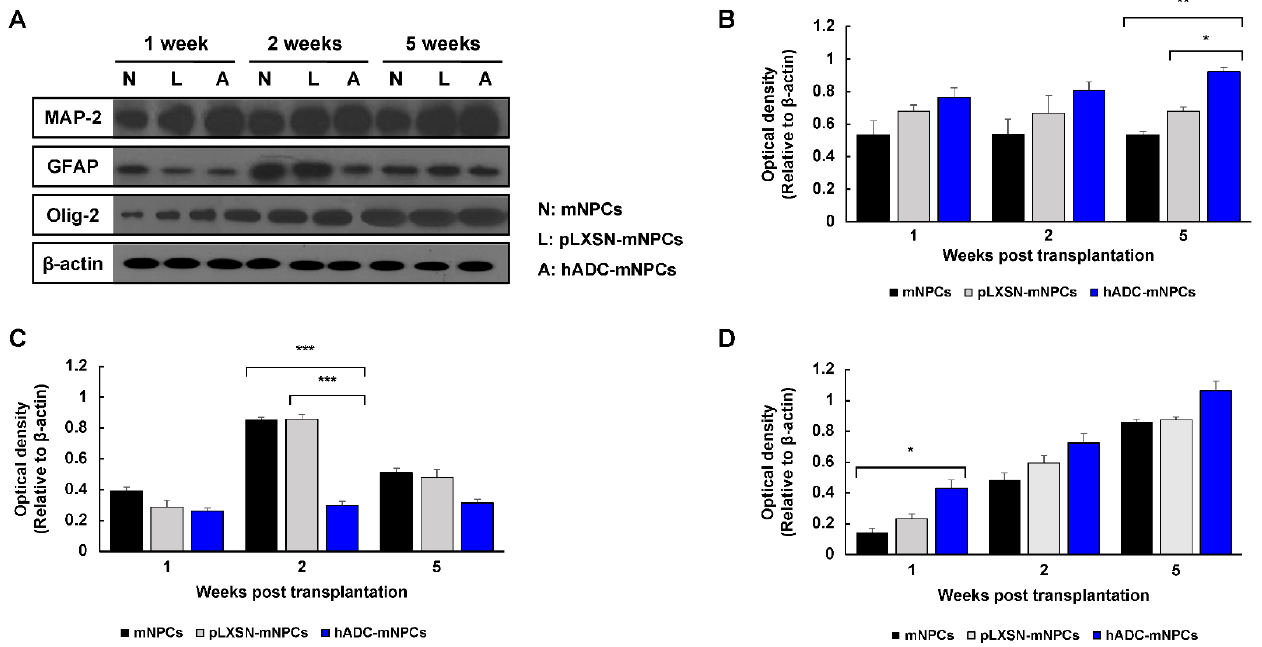
Figure 3. Western blotting of MAP-2, GFAP, Olig-2, and β-actin from T8, T9 (lesion area), and T10 at 1, 2, and 5 weeks after cell transplantation. ( A ) Representative Western blots of MAP-2, GFAP, Olg-2, and β-actin. ( B ) Quantification of MAP-2, showing that hADC-mNPC mice had significantly higher expression than pLXSN-mNPC or mNPC mice at 5 weeks post-transplantation. ( C ) Quanti- fication of GFAP, showing a significant decrease in the hADC-mNPC group compared with the pLXSN-mNPC and mNPC groups at 2 weeks post-transplantation. ( D ) Quantification of Olig-2, showing a significant increase in the hADC-mNPC group compared with the pLXSN-mNPC and mNPC groups at 1 week post-transplantation. Data are presented as the mean ± SEM. ( n = 5 per sample, * p < 0.05, ** p < 0.01, *** p < 0.001).